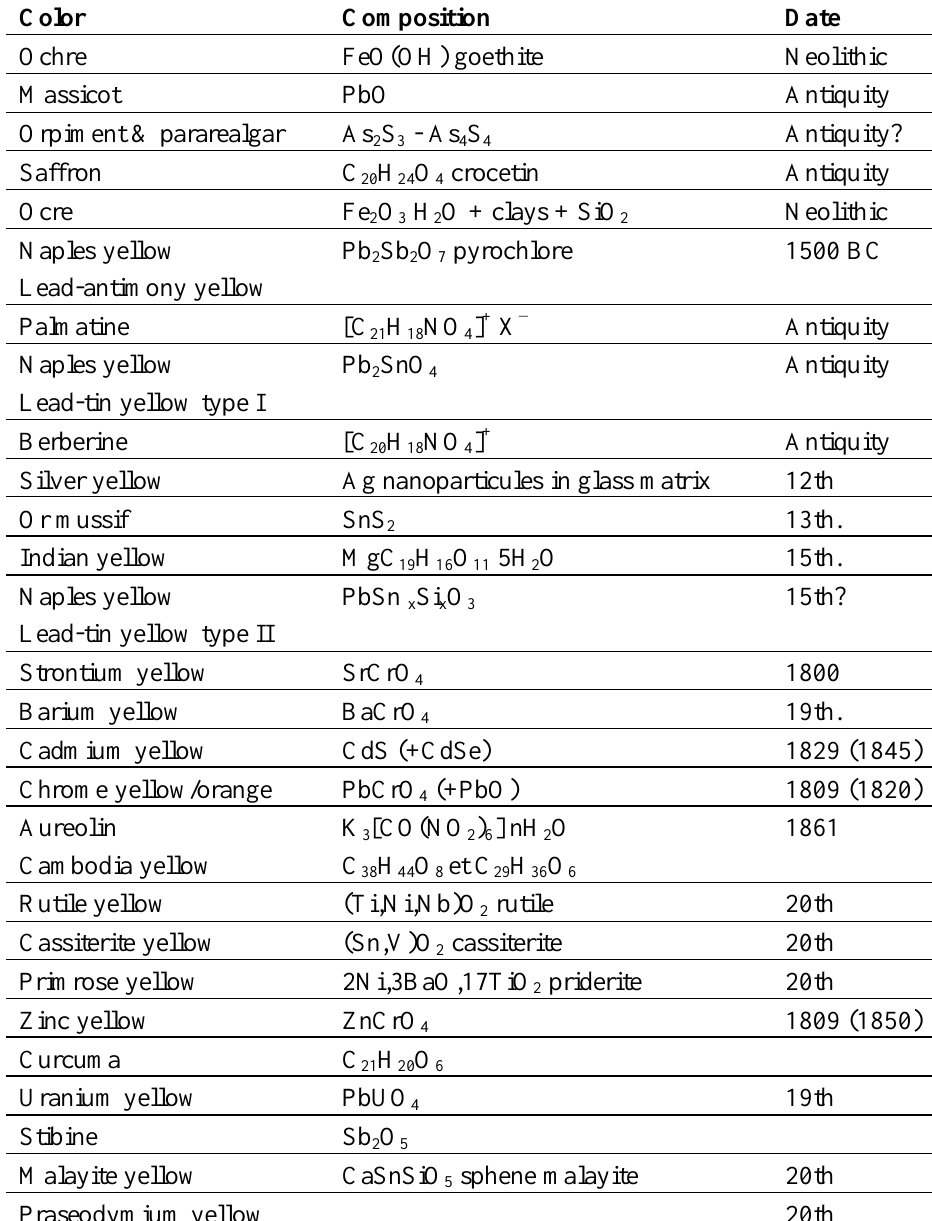
Table 3. Name and composition of yellow pigments and coloring agents. Dates of innovation (first production) are